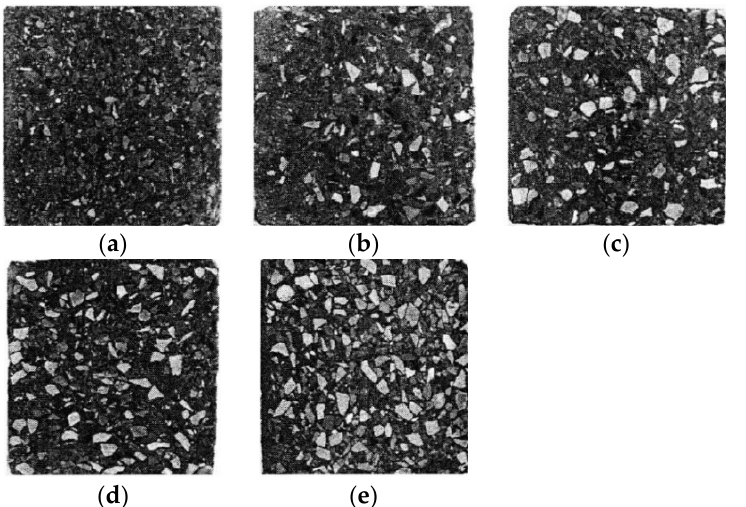
Figure 2. Cross-sections of concrete with different post-filling coarse aggregate ratios. ( a ) reference concrete; ( b ) PFCC with 10% PFR; ( c ) PFCC with 15% PFR; ( d ) PFCC with 20% PFR; ( e ) PFCC with 25% PFR. Table 2. Mechanical properties of concrete.